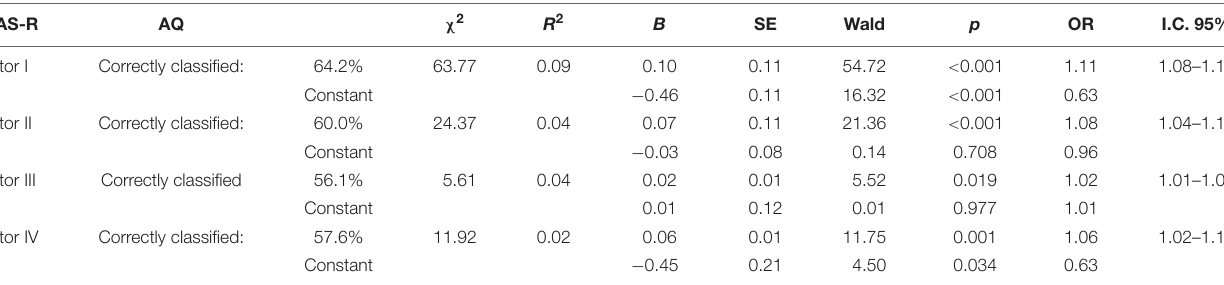
TABLE 7 | Logistic regression model for the probability of presenting high Verbal Aggression based on the school refusal behavior. SRAS-R